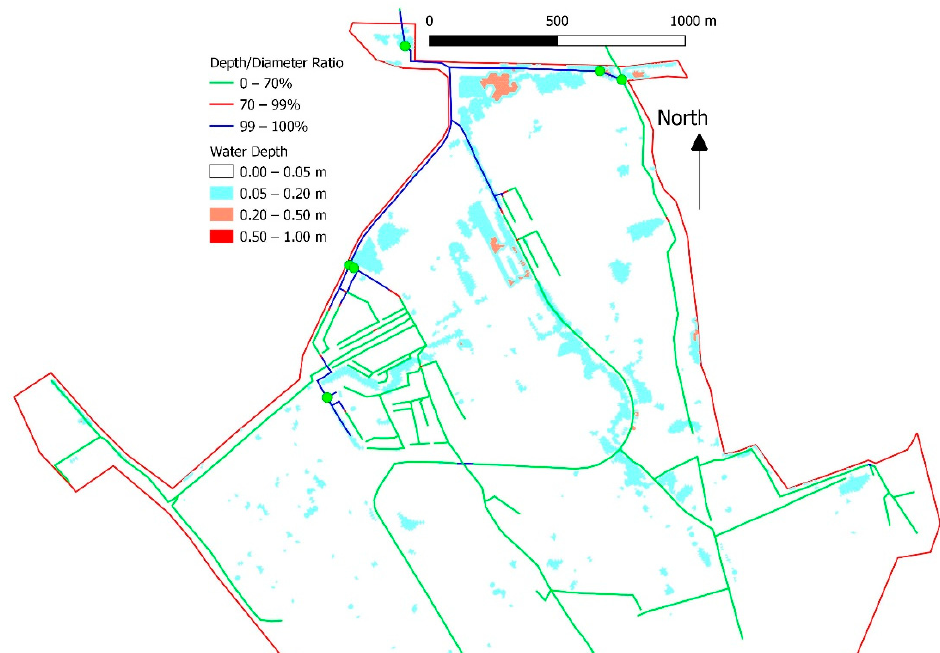
Figure 12. Results of validation event on 5 October 2021 (rain 15.4 mm). Part-full pipe flow (green lines) and surcharging pipe (blue lines). The green point indicates the local overflow at Piazza Castelforte and at WTP.